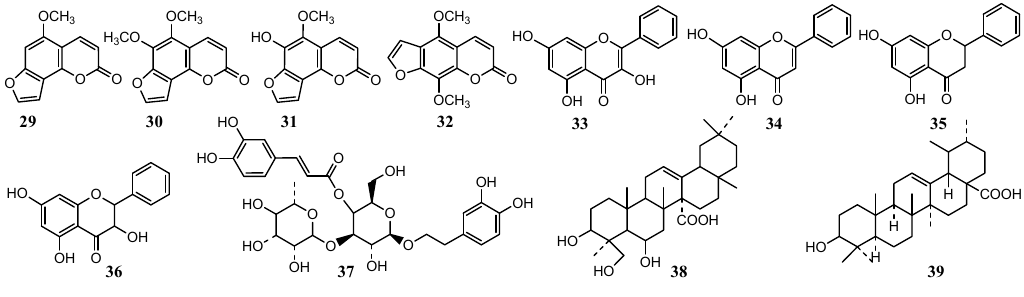
Figure 3. Chemical structures of antifungal constituents 29–39.